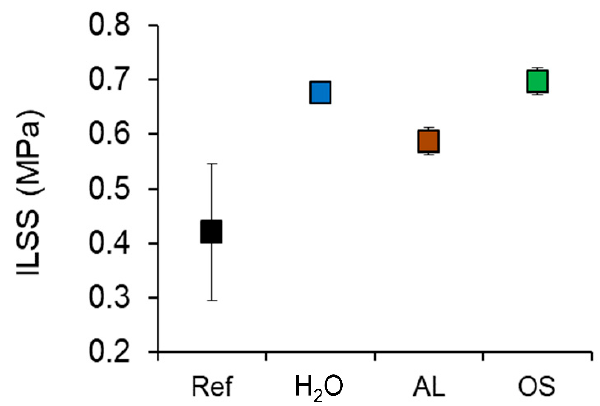
Figure 6. Mechanical characterization of plywood samples made of reference (Ref), densified water-soaked (H 2 O), densified alkali-treated (AL) and densified organosolv-treated (OS) spruce veneers conditioned at 20 ◦ C and 65% relative humidity by interlaminar shear tests. ( n = 6 for Ref; n = 6 for H 2 O; n = 6 for AL; n = 6 for OS).